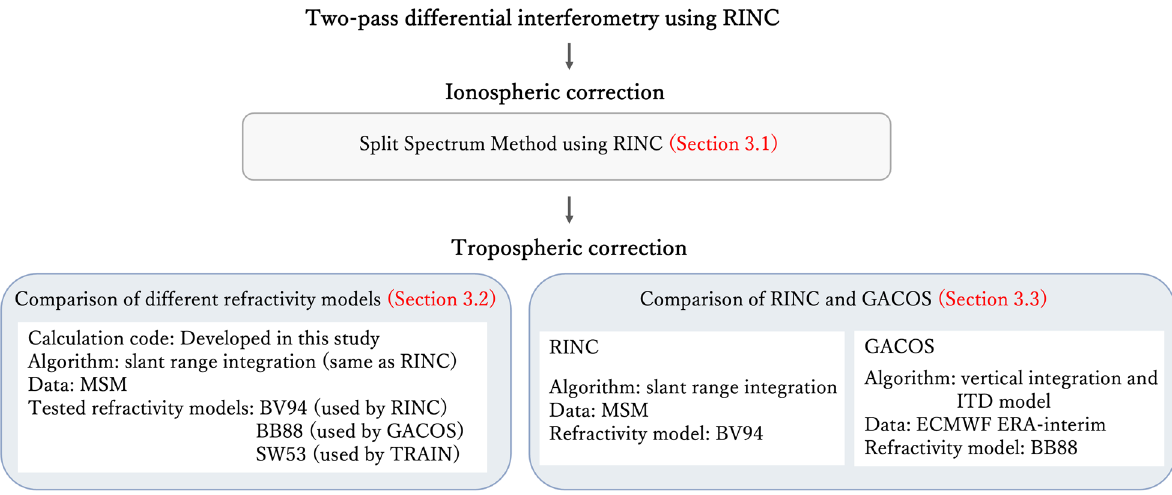
Fig. 1 Framework of this study to perform the comparison of different tropospheric correction methods. BV94, BB88, and SW53 refer to the refractivity models of Bevis (1994), Berrada-Baby et al. (1988), and Smith and Weintraub (1953),